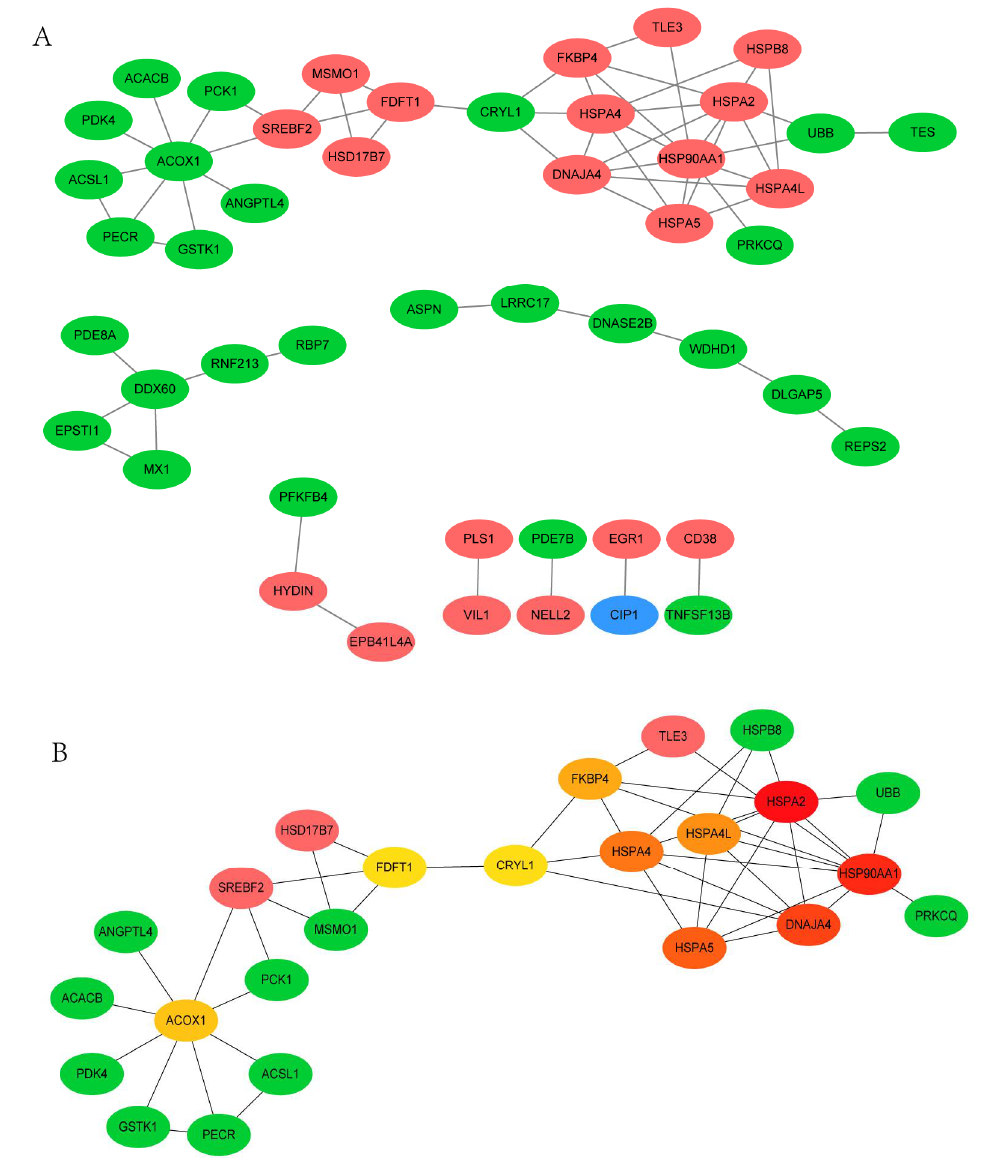
Figure 3. ( A ). PPI network analysis of differentially expressed genes (DEGs) between 35 and 12 weeks. A total of 48 nodes and 63 edges were screened. The green node represents the downregulated DEGs, and the red one represents the upregulated DEGs. ( B ). The color of nodes represented the MCC score of each gene. The color ranging from red to green represents high to low rank of DEGs.